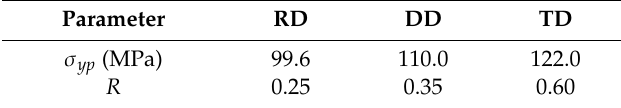
Table 1. Experimentally measured mechanical properties of the Zn-20 alloy [1].